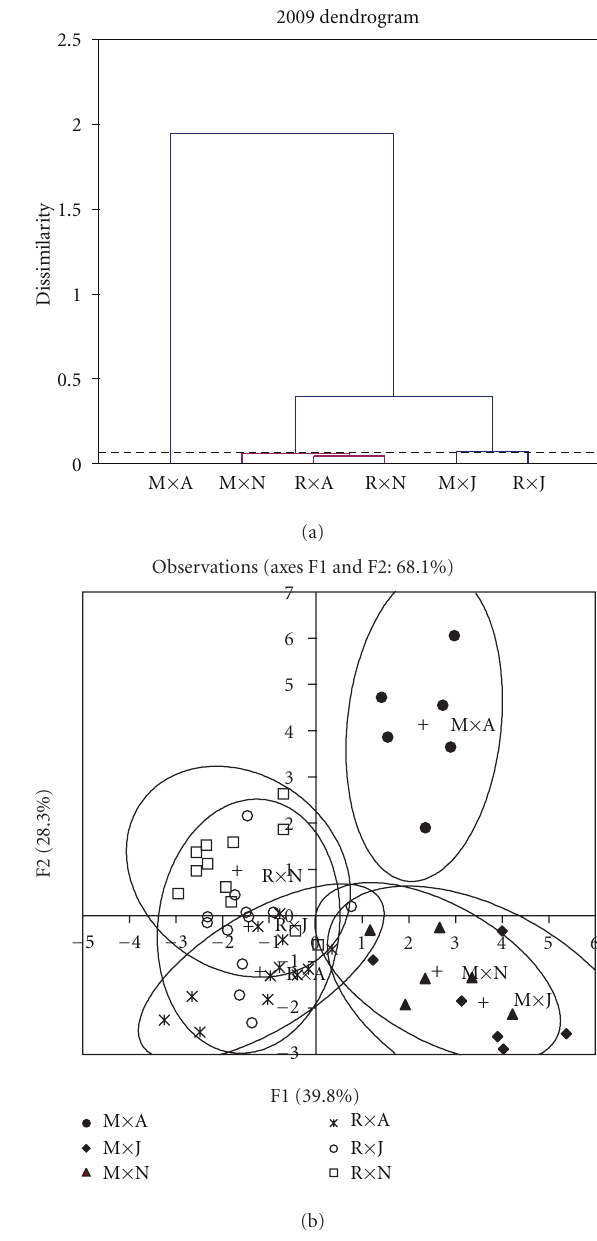
Figure 12: Results of cluster analyses conducted during 2009 on the community level physiological profiles of the soils, as measured using the Biolog EcoPlate method (a) dendrogram and (b) discriminant analysis (M = monoculture and R = rotation, J = June, A = August, and N =